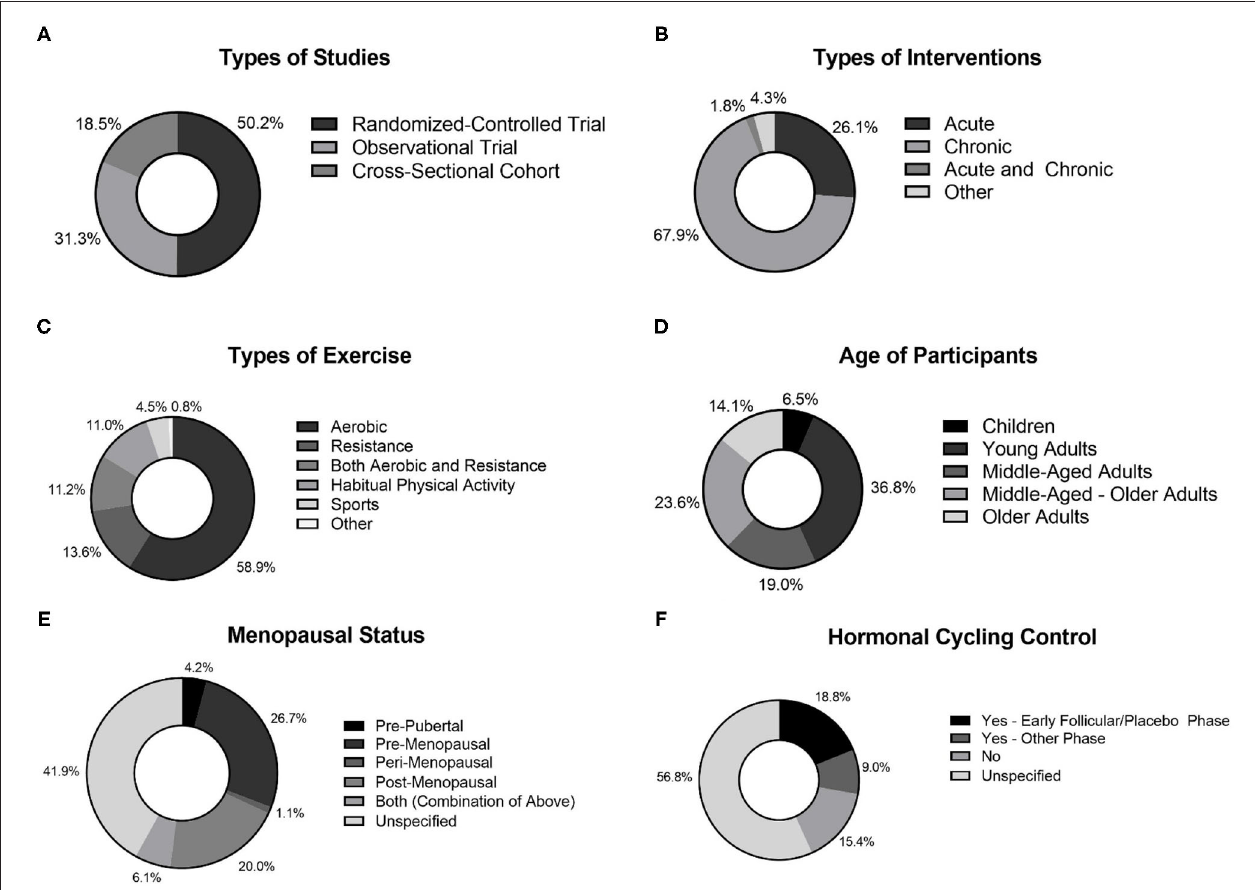
FIGURE 2 | Study characteristics of studies included in review. (A) Type of studies; (B) Types of interventions; (C) Types of exercise; (D) Age of participants; (E) Menopausal status of female participants; (F) Hormonal cycling control in female participants.